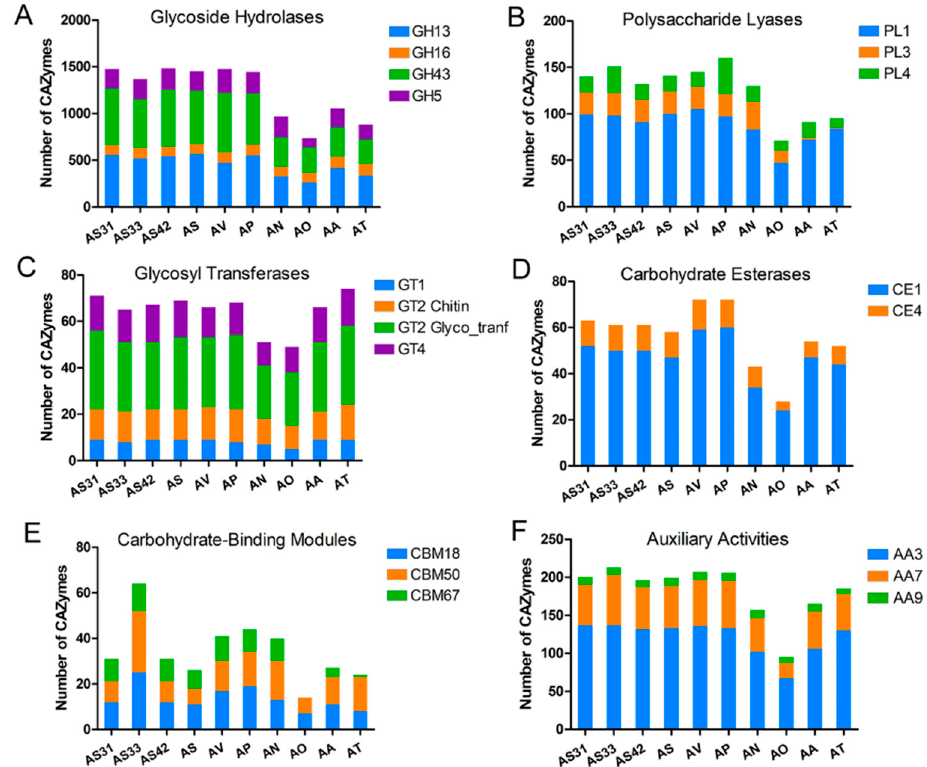
Figure 6. Numbers of genes related to CAZyme from the genomes of AS31, AS33, and AS42. ( A ) numbers of genes dominated in categories of glycoside hydrolase (GH); ( B ) numbers of genes dominated in categories of polysaccharide lyases (PL). ( C ) numbers of genes dominated in cate- gories of glycosyl transferase (GT); ( D ) numbers of genes dominated in categories of carbohydrate esterase (CE); ( E ) numbers of genes dominated in categories of carbohydrate-binding module (CBM); ( F ) numbers of genes dominated in categories of auxiliary activity (AA).